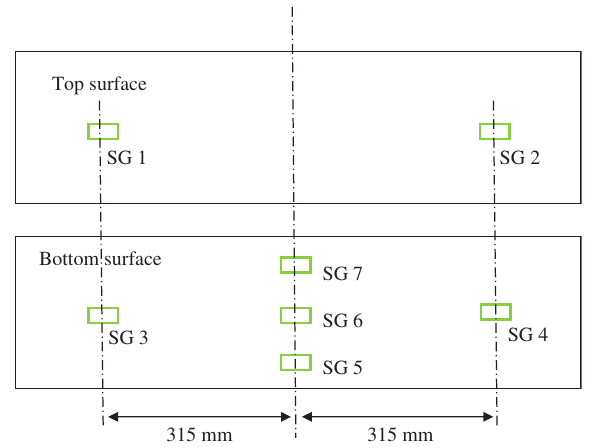
Figure 15: Positions of the strain gauges (SG).